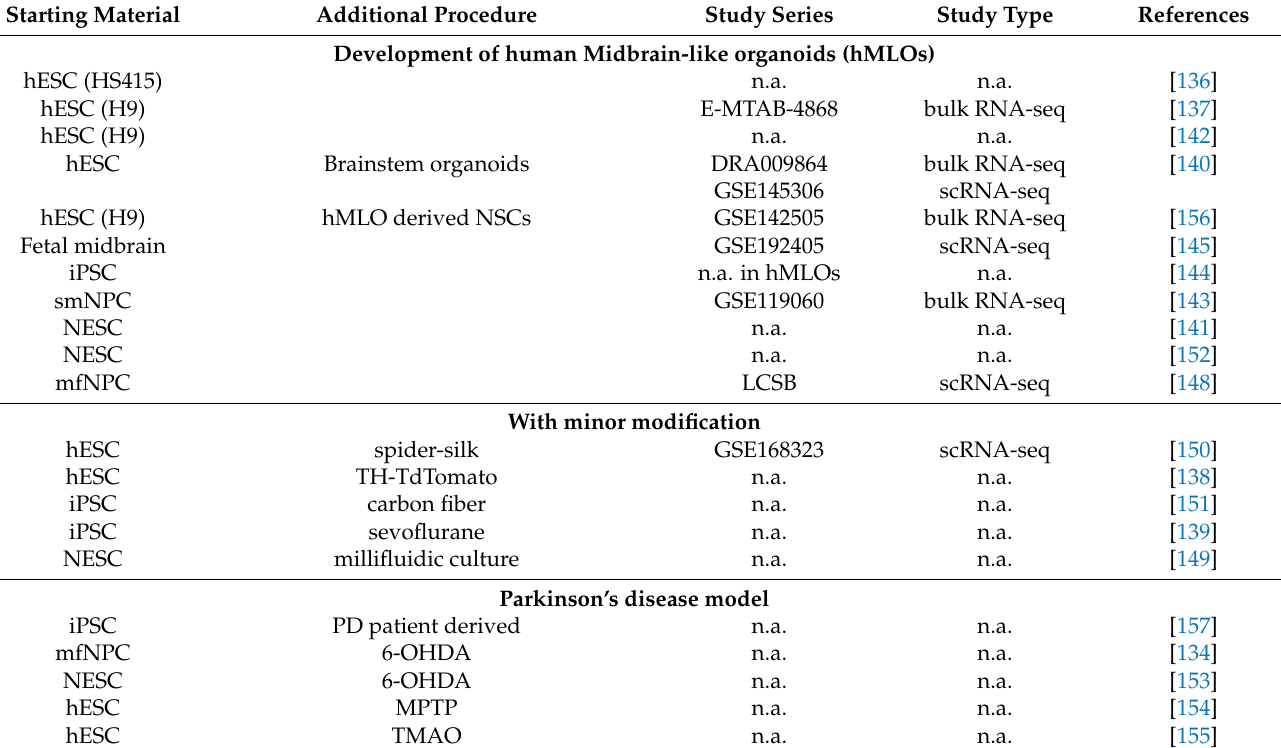
Table 2. List of reported human midbrain-like